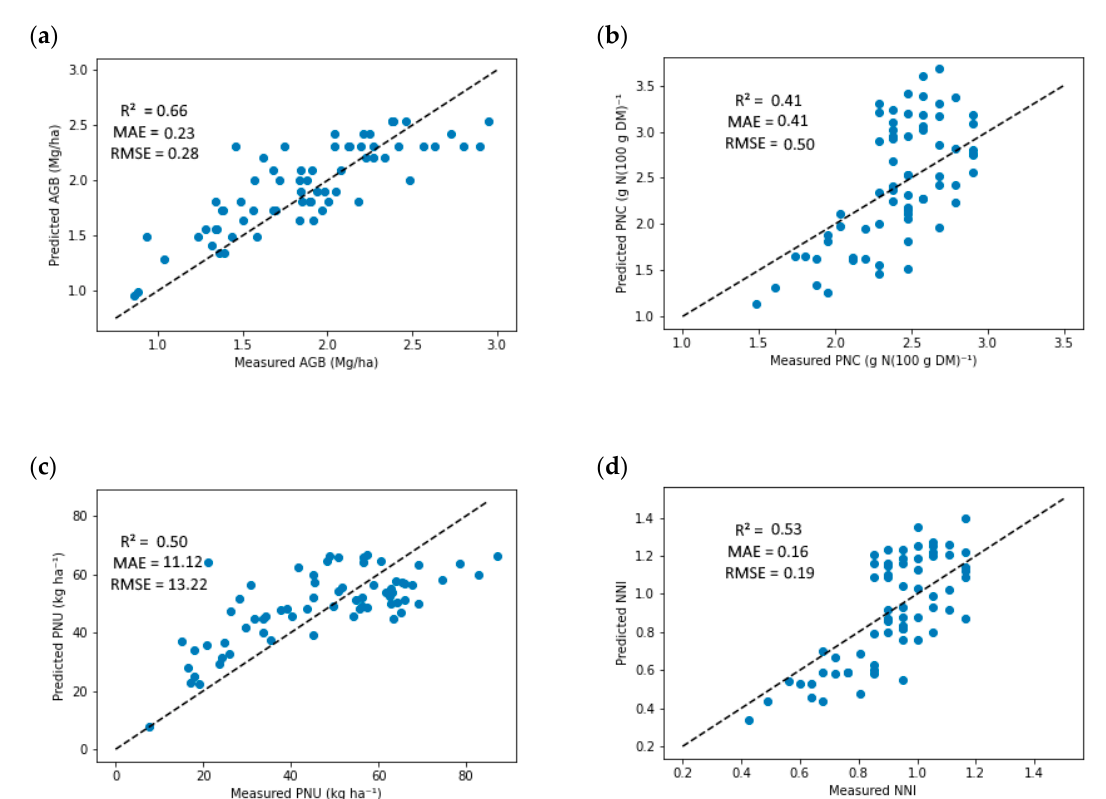
Figure 5. Measured versus predicted ( a ) aboveground biomass (AGB) using SR NDVI, ( b ) plant N concentration (PNC) using SR CCCI, ( c ) plant N uptake (PNU) using SR eCCC, and ( d ) N nutrition index (NNI) using SR CCCI. Table 4. eXtreme gradient boosted (XGB) model performance using different levels of Crop Circle Phe- nom sensor and management variables for predicting aboveground biomass, plant N concentration, plant N uptake, and N nutrition